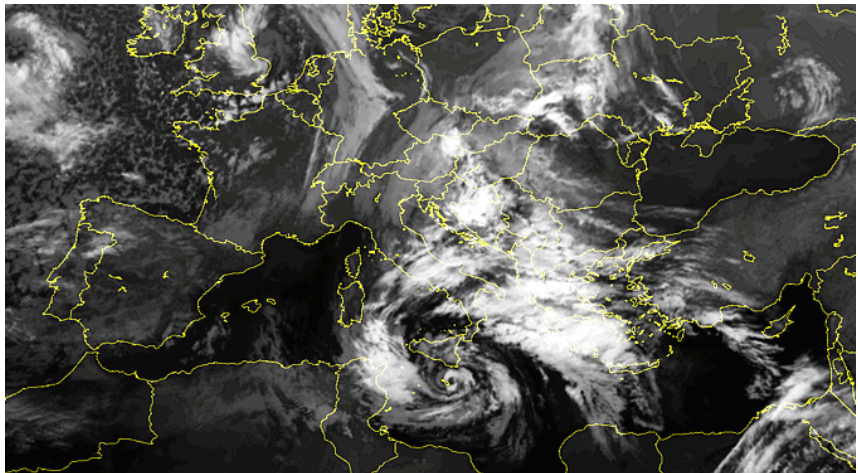
Figure 1. IR-MSG satellite imagery at 18:00UTC on 7 November